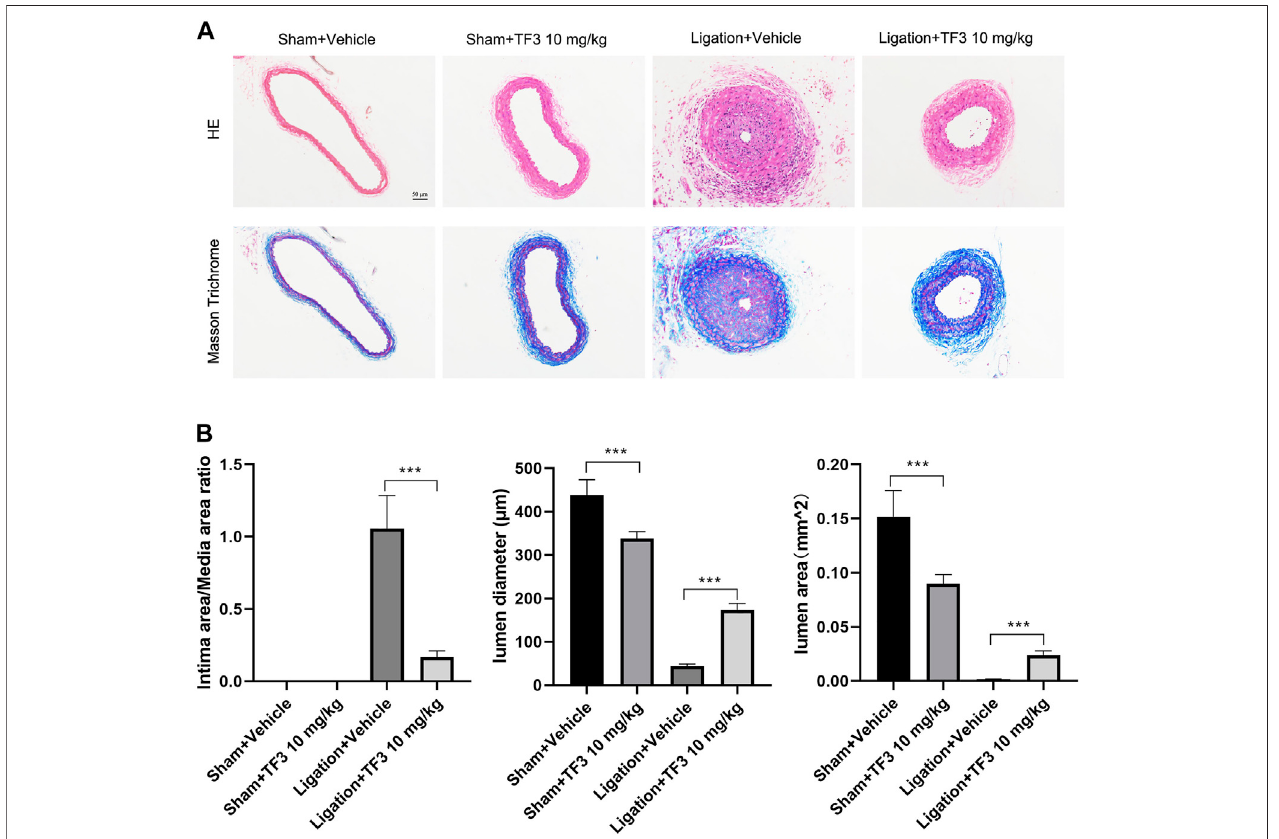
FIGURE 1 | Effect of thea fl avin-3,3 ′ -digallate (TF3) on carotid artery ligation – induced neointimal hyperplasia. (A) TF3 (10 mg/kg) or vehicle was intraperitoneally injected after carotid artery ligation. Mice were sacri fi ced 14 days after the surgery. Hematoxylin and eosin-stained and Masson trichrome-stained sections of all groups areshown.Scalebar,50 μ m. (B) Quanti fi cationoftheratioofintimatomedia(I/Mratio),lumendiameter,andlumenarea.Thedataarepresentedasthemean±SEM( n = 7). *** p < 0.001.